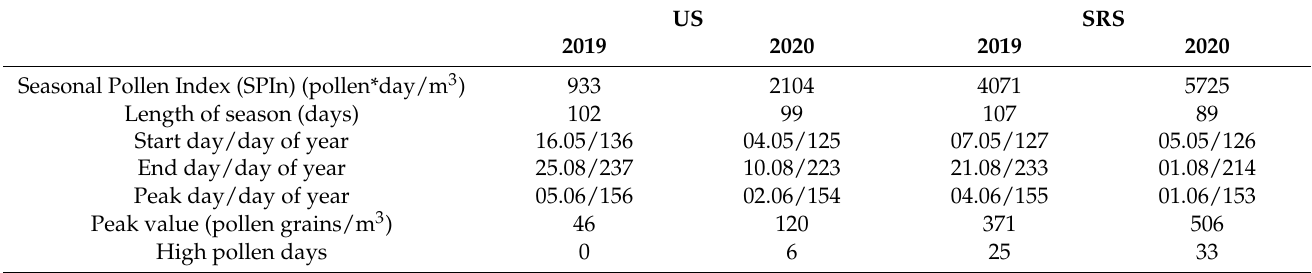
Figure 3. Poaceae pollen concentration (daily mean values) for the SRS (black) and US (grey) locations in the greater area of Ingolstadt. Dashed lines indicate start and end dates of the corresponding grass pollen season ( a ) 2019 and ( b ) 2020. Table 3. Characteristics of the grass pollen season 2019 and 2020 for US (urban station) and SRS (semi-rural station) in the greater area of Ingolstadt.